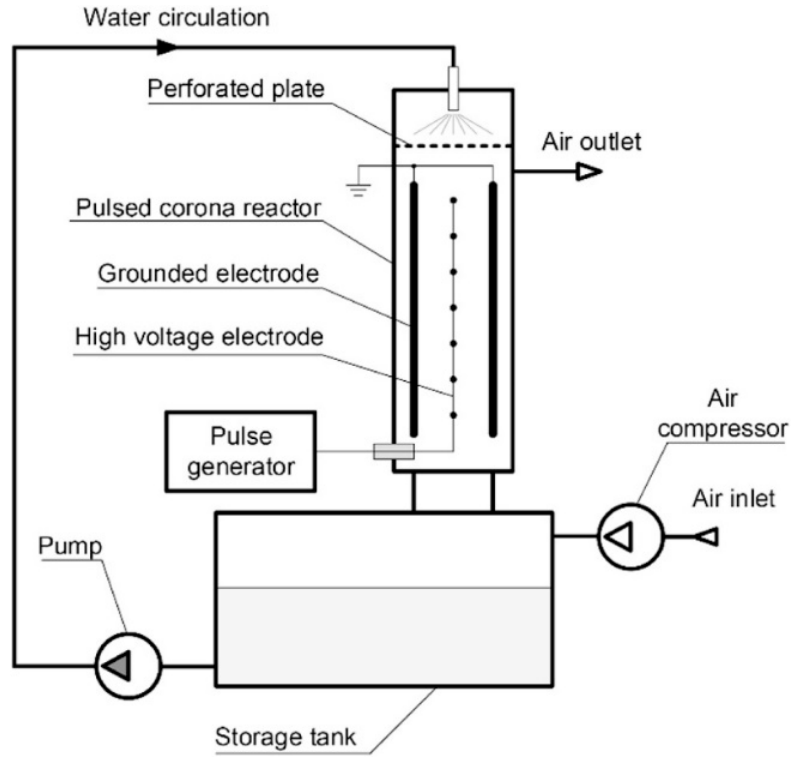
Figure 5. Schematic illustration of the PCD device.